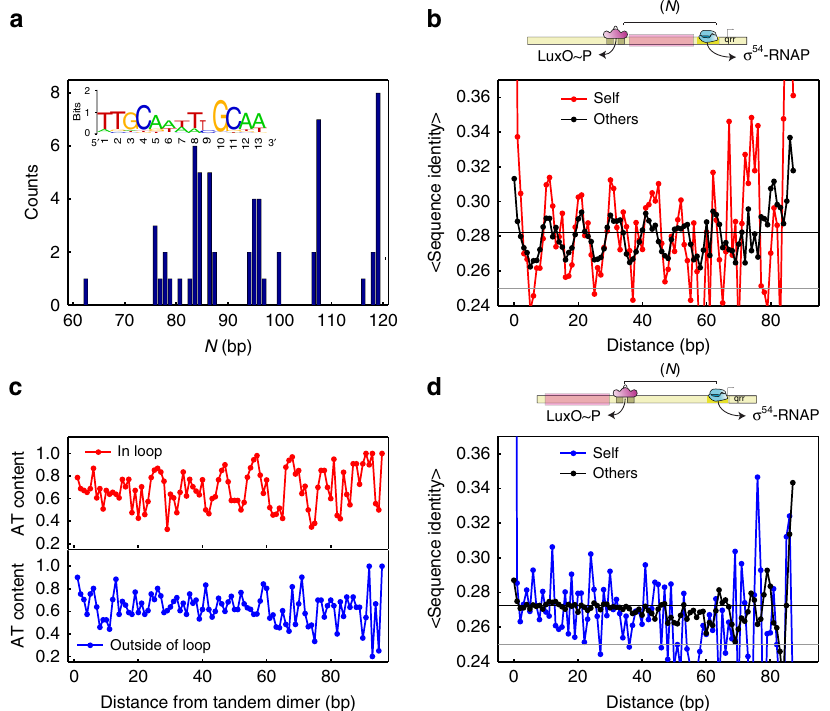
Figure 6 | Sensitivity to the DNA’s helical repeat in the Vibrio qrr enhancers. ( a ) Histogram of loop lengths for all putative loop sequences. Inset, LuxO consensus sequence. ( b ) Relative identity of all putative loop sequences to themselves (red) and to all other putative loop sequences (black). Horizontal lines indicate the expected identity level for sequences with equal probability for all four nucleotides (grey) and for the putative loop sequences (black) (see the Supplementary Methods). ( c ) AT nucleotide content as function of position for the loop sequences (top, red) and for the non-looping upstream sequences (bottom, blue). ( d ) Relative identity for all non-looping upstream sequences (from the tandem LuxO binding sites, see top schematic) to themselves (blue) and to all other upstream sequences